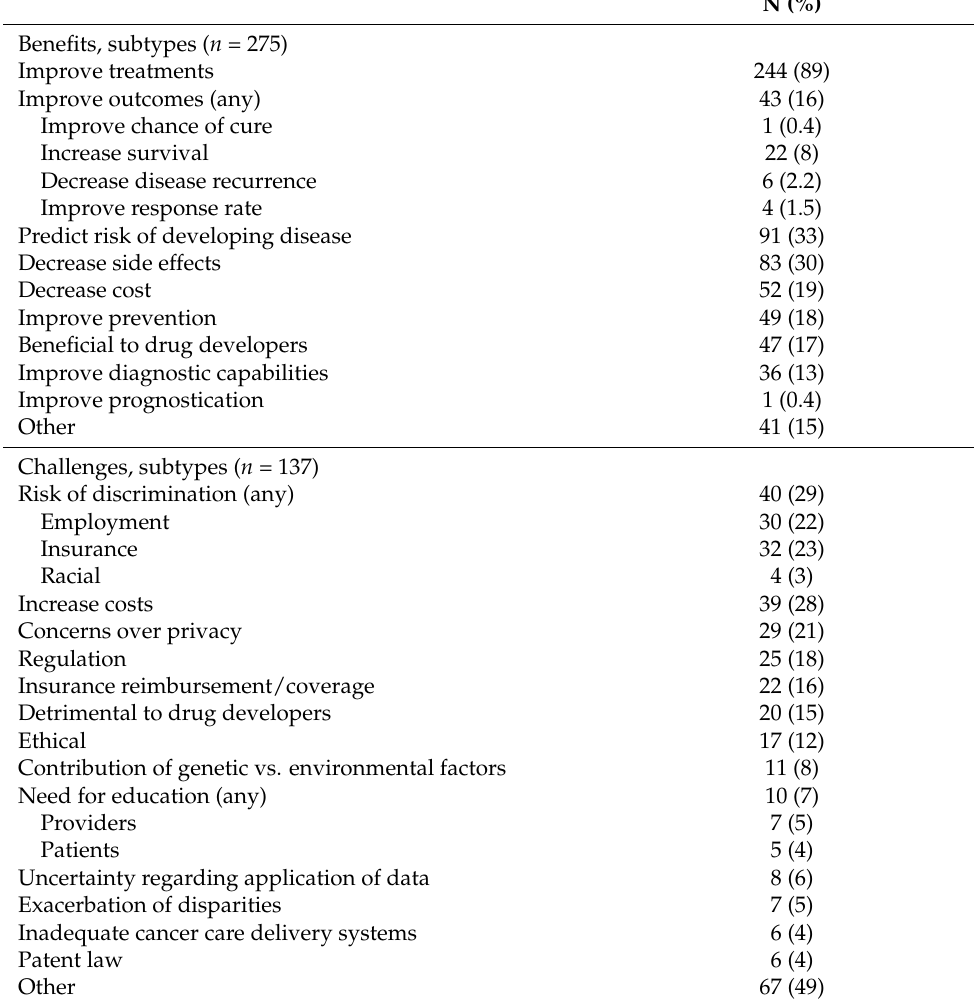
Table 2. Reported benefits and challenges of personalized